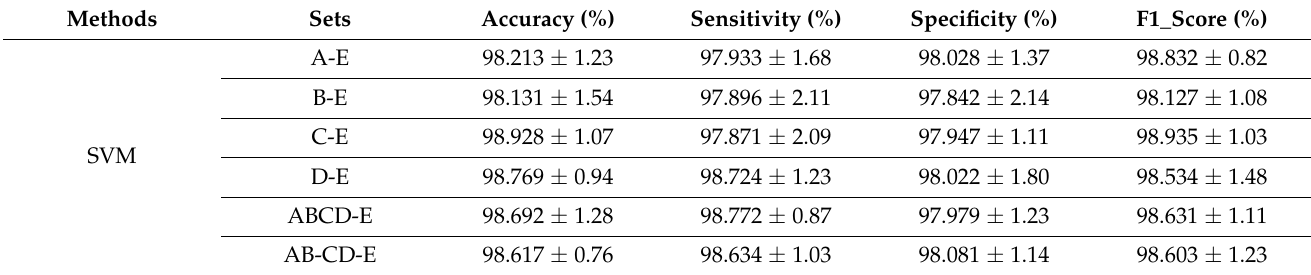
Table 7. Results for the Bonn dataset using different classifier methods without mRMR technique.